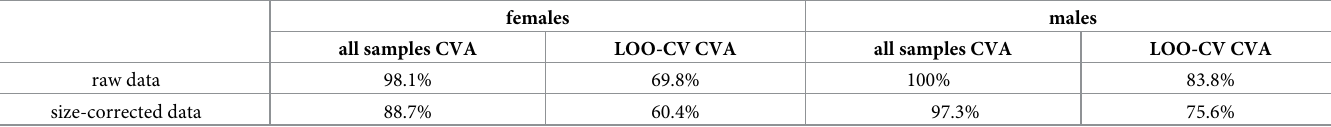
Table 4. Percentage of specimens correctly classified by all samples CVA and LOO-CV CVA on raw and size-corrected data of females and males, respectively.